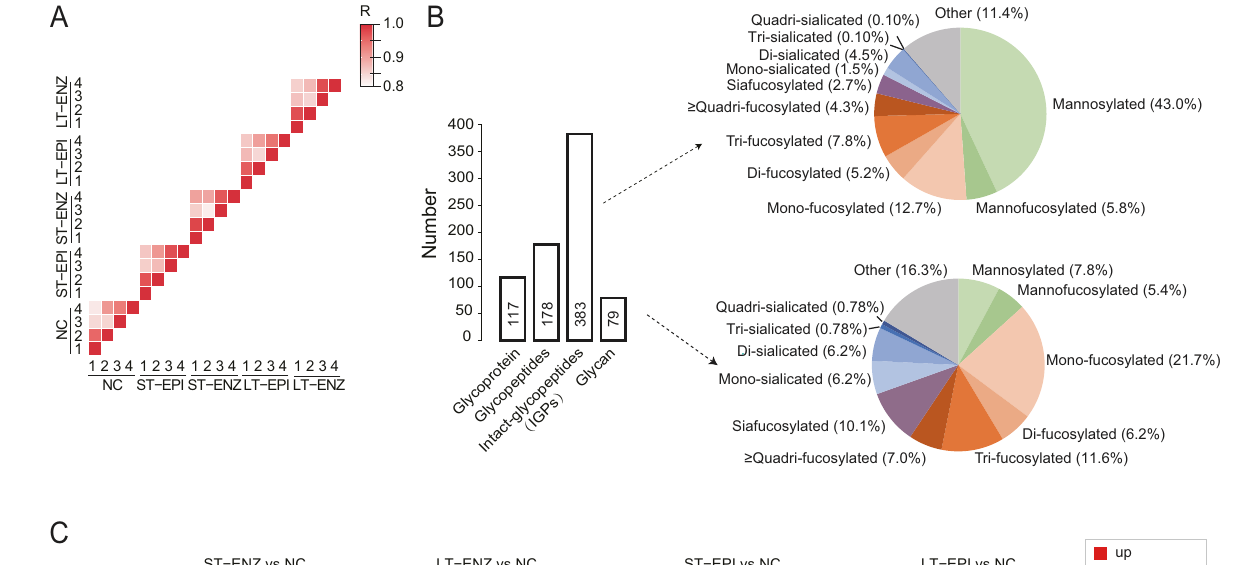
(0.78%)Other (16.3%) (0.78%)Quadri-sialicated (6.2%)Tri-sialicated (6.2%)Di-sialicated